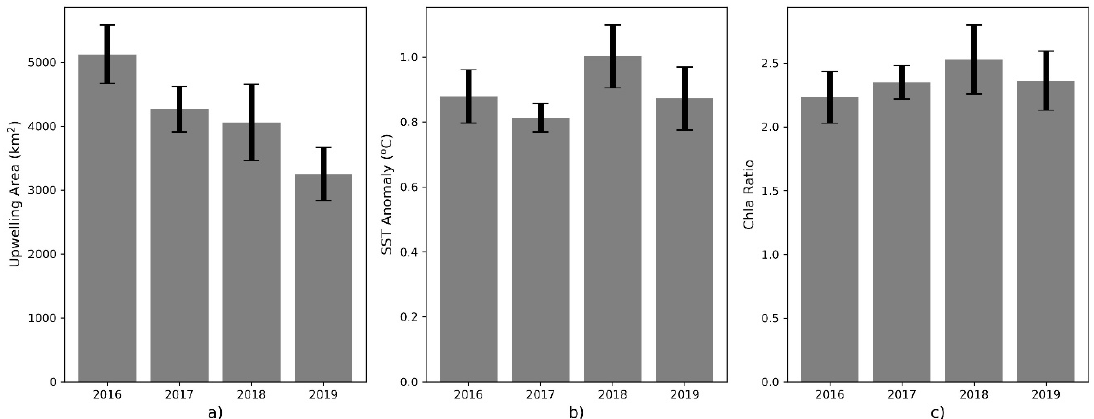
Figure 11. The interannual variations of the upwelling characteristics; ( a ) upwelling area, ( b ) SST anomaly, ( c ) Chla ratio. The year 2015 is not included as it is an incomplete year of data. The error bars indicate 95% confidence intervals.